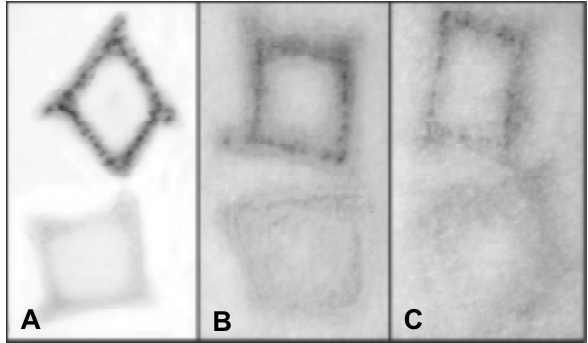
Fig. 2. Detection of Faba bean necrotic yellows virus (FB- NYV) by TBIA in phloem vessels of infected faba bean tissue blotted on nitrocellulose membrane (A), Soporcel white paper (B) and HP non-glossy plotter paper (C). In all duplicate stem blots, the healthy tissue is at the bot- tom of the picture and the FBNYV-infected faba bean tissue at the top.